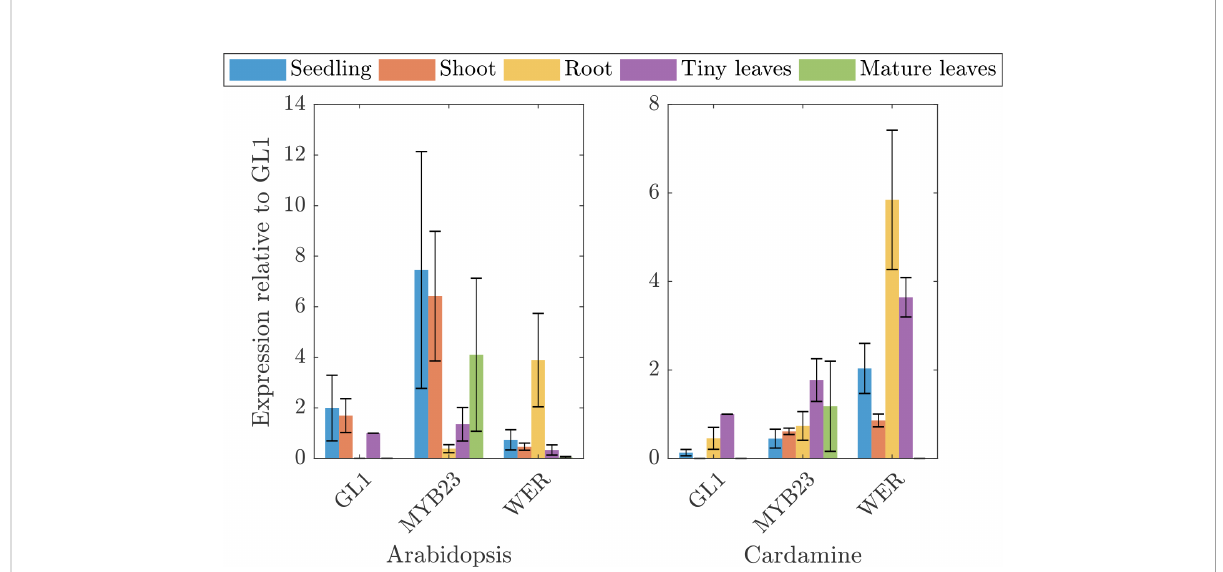
FIGURE 2 Quantitative expression analysis of three MYB homologs in A. thaliana and C. hirsuta in different tissues. Depicted is the expression of GL1, MYB23 , and WER in Arabidopsis thaliana and Cardamine hirsuta in seedlings (blue), shoots (red), roots (yellow), tiny leaves (purple), and mature leaves (green), relative to GL1 expression in tiny leaves of the respective